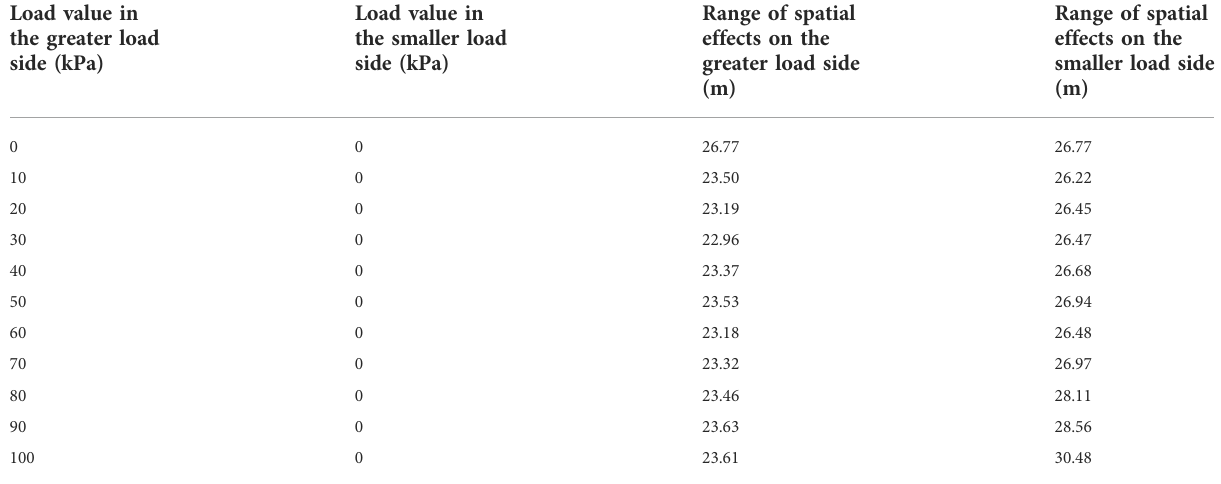
TABLE 4 Range of spatial effects on both sides of the foundation pit under asymmetric